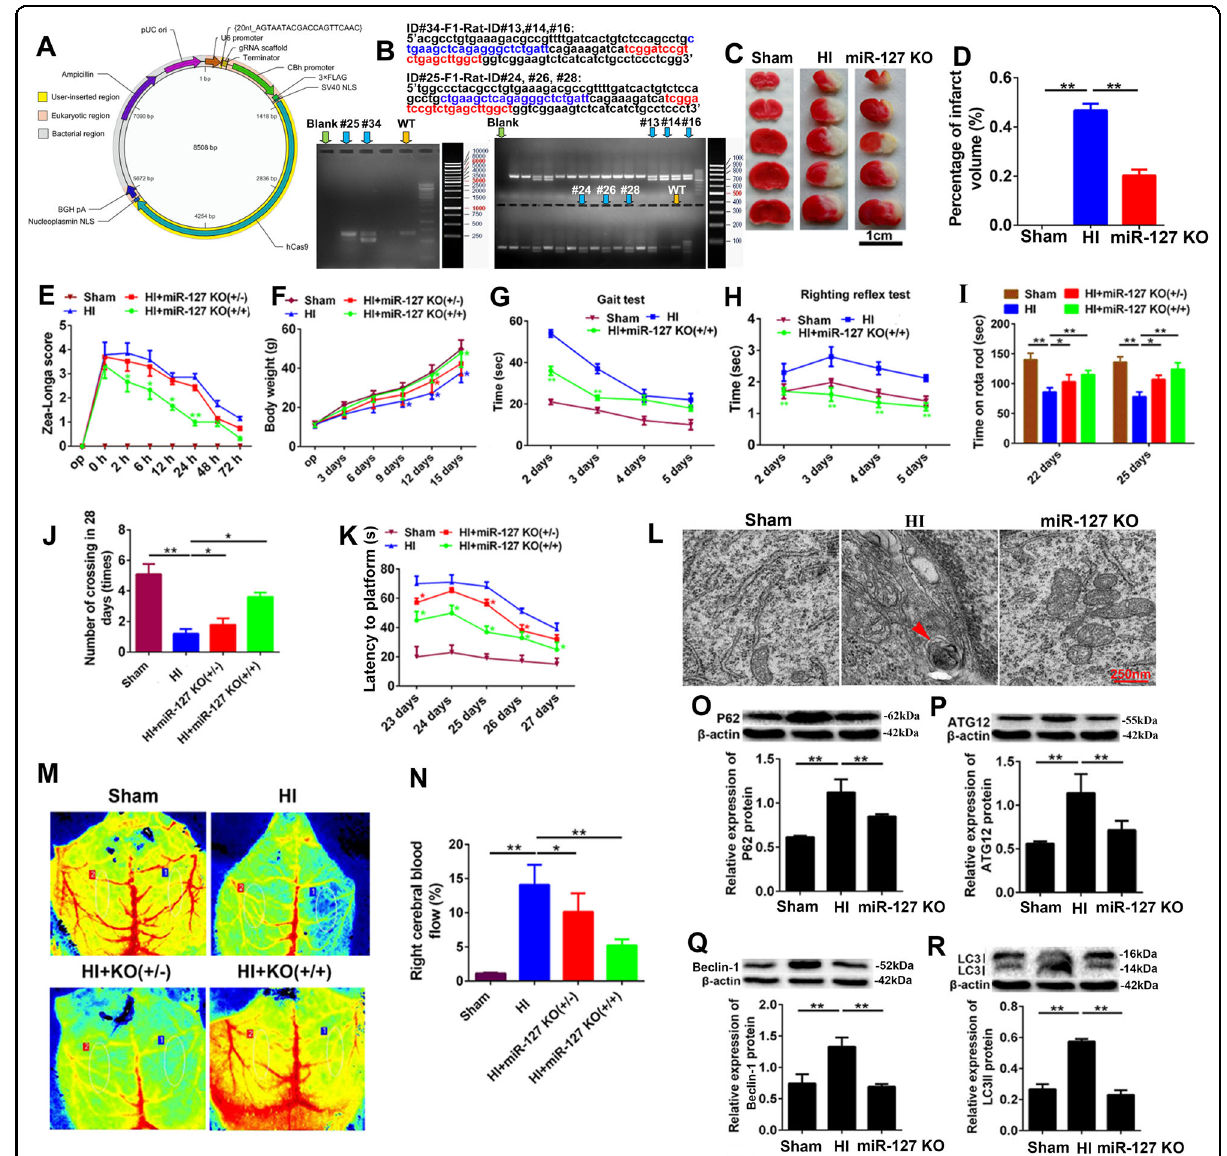
Fig. 3 KO-miR-127-3p relieved autophagy and neurological impairment in vivo. A Vector construction drawing of KO-miR-127-3p rats. B The examination of miR-127-3p expression in KO-miR-127-3p. F0 founders PCR screening: the molecular weight of wild type is 677 bp, # 25 missing 133 bp, # 34 missing 129 bp. F1 founders PCR screening: the molecular weight of wild type is 677 bp, # 24, 26 #, # 28 missing 133 bp, # 13, # 14, # 16 missing 129 bp. C , D TTC staining of rat brains. Images above the graph show representative slices from each group. Brains were sliced, stained with TTC, and fi xed to delineate live (red) from dead or infarcted tissue (white). Infarcts were quanti fi ed by planimetry and expressed as a percentage of risk zones. Scale bar = 1 cm. E Zea-longa score of rats. F Results of body weight. G , H Grip times and righting re fl ex time were assessed in 2 d, 3 d, 4 d, and 5 d after HI. I Time on rota rod was assessed in 22 d and 25 d after HI. J Number of crossing in 28 days. K Latency to plant forms. L Representative EM images of autophagic vacuoles were shown. Scale bar = 250 nm. The arrows depict autophagosomes. M , N Right cerebral blood fl ow of HI rats. O , P – R The levels of P62, ATG12, Beclin-1, LC3 I, and LC3II were detected by WB in Sham group, HI group and KO-miR-127-3p group. Data are shown as mean ± s.d. ** P < 0.01 with one-way ANOVA or Kruskal – Wallis, n = 6. HI hypoxic ischemic, KO knock out, WB western blot, TTC 2,3,5-triphenyl-2H- tetrazolium chloride, D days, WT wild type, Mut mutant, NC negative control, H